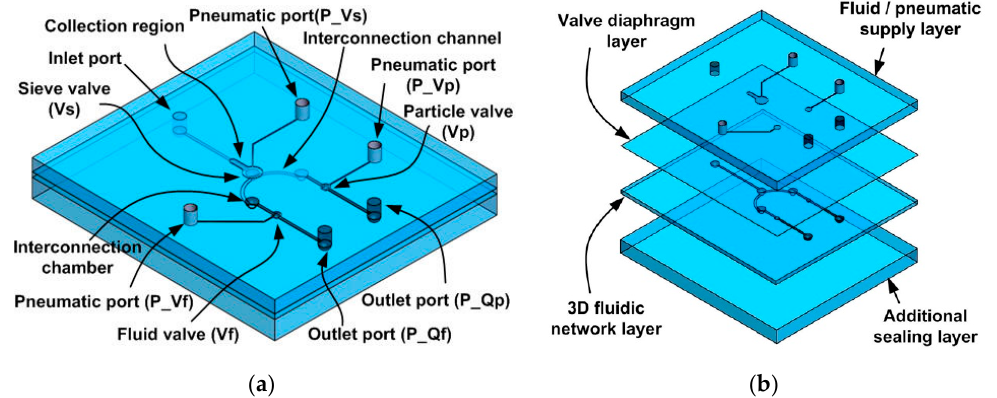
Figure 1. The pneumatically driven microfluidic platform that concentrates particles. ( a ) A schematic of the concentrator. ( b ) Device assembly. (P: port, Q: flowrate, f: fluid, p: particle, V: valve, s: sieve).